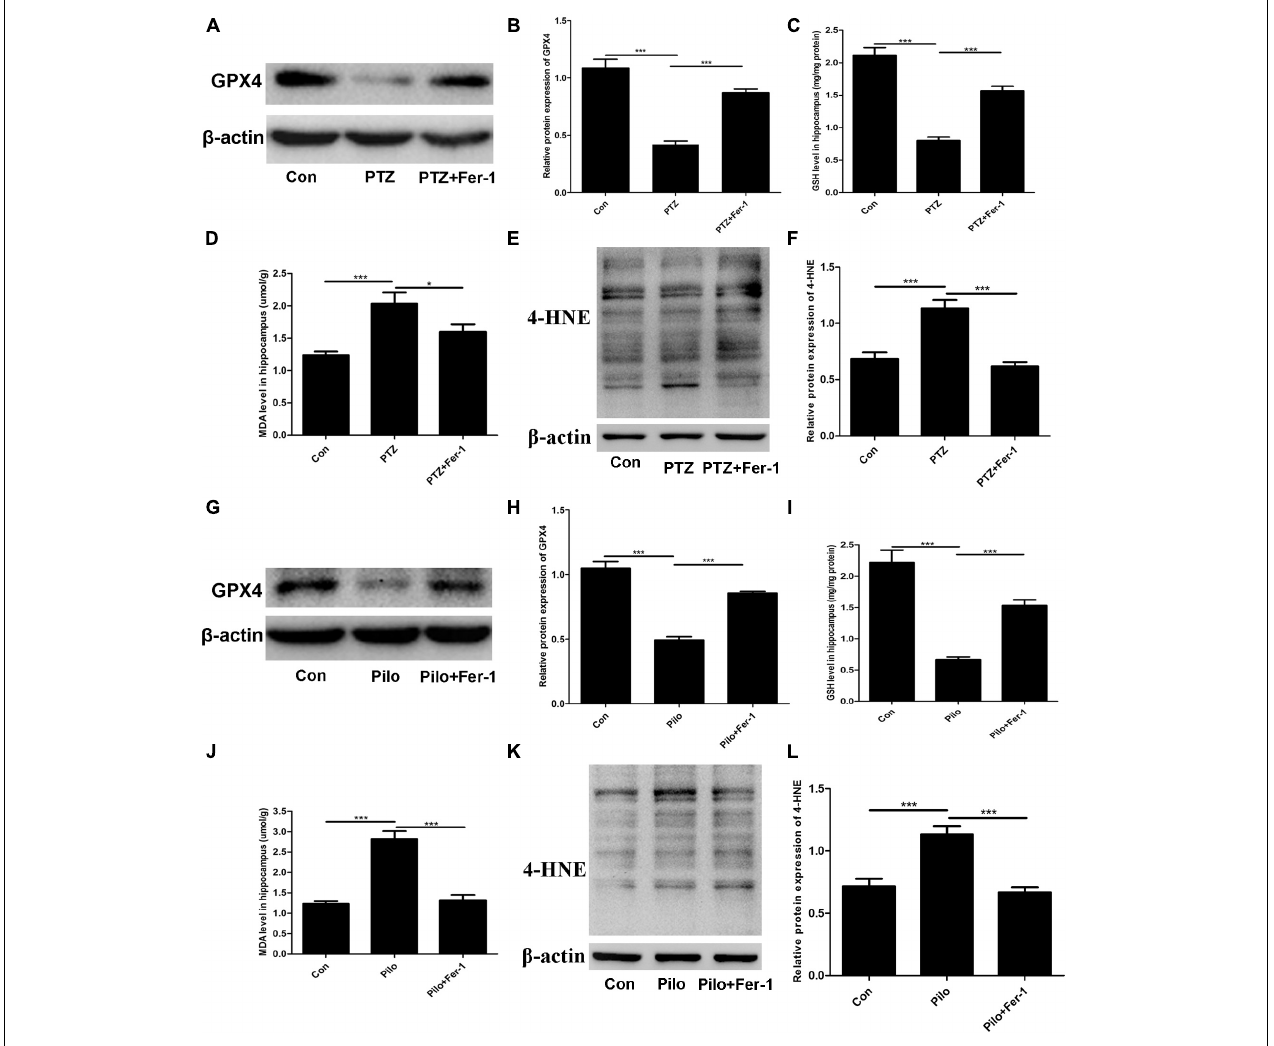
FIGURE 4 | Fer-1 enhances GPX4 protein expression and GSH level as well as decreasing MDA content and the 4-HNE level in the hippocampus of PTZ- and Pilo-treated mice. (A , B , G , H) GPX4 protein expression in the hippocampus of PTZ- and Pilo-treated mice ( ∗∗∗ p < 0.001, n = 4). (C , I) Detection of the GSH level in the hippocampus of PTZ- and Pilo-treated mice ( ∗∗∗ p < 0.001, n = 6). (D , J) Detection of the MDA content in the hippocampus of PTZ- and Pilo-treated mice ( ∗∗∗ p < 0.001; ∗ p < 0.05, n = 6). (E , F , K , L) Detection of the 4-HNE level in the hippocampus of PTZ- and Pilo-treated mice ( ∗∗∗ p < 0.001, n = 6). In the Pilo-matched control group, diazepam treatment alone did not have any effect on the GPX4, GSH, MDA, and 4-HNE